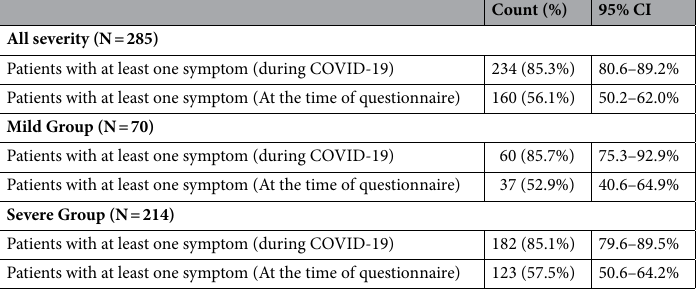
Table 2. Patients who have had at least one or more symptoms. CI, confidence interval; COVID-19, Mild Group, Asymptomatic and Mild; Severe Group, Moderate I/II and Severe coronavirus disease 2019.